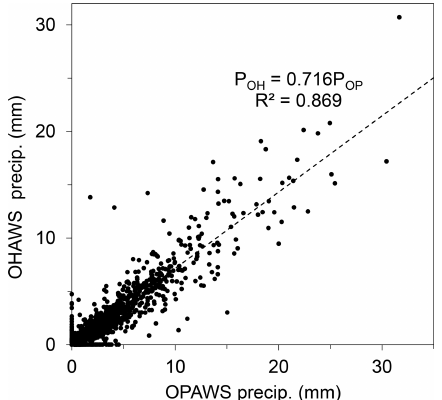
Figure 3. Relationship between daily winter precipitation at OHAWS ( P OH ) and OPAWS ( P OP ). Daily precipitation was cor- rected for instrument noise- and wind-induced undercatch. Plotted daily precipitation was sampled from the entire monitoring period (2004–2017) for days between 1 December and 30 April, for which both OPAWS and OHAWS were recording and correctly function- ing the entire day. R 2 is the coefficient of